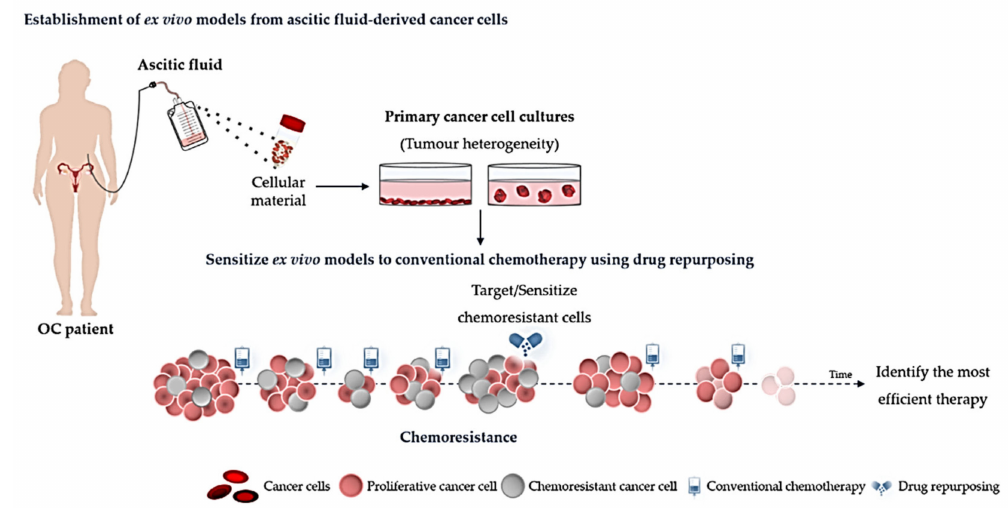
Figure 2. Establishment of ex vivo models from ascitic fluid-derived cancer cells to perform drug e ffi cacy tests. Combination of drug repurposing (e.g., pitavastatin, metformin,